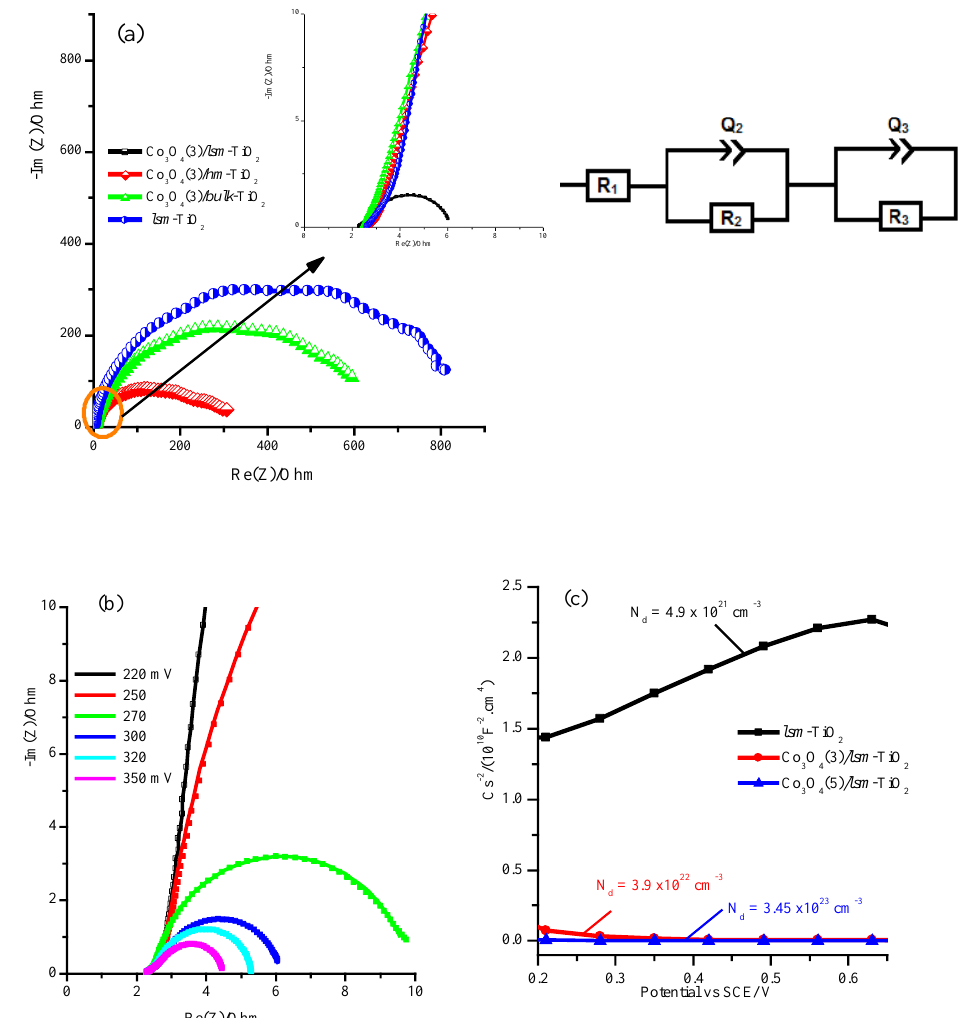
Figure 7. ( a ) Nyquist plots of lsm -TiO 2 , Co 3 O 4 (3) / lsm -TiO 2 , Co 3 O 4 (3) / hm -TiO 2 , and Co 3 O 4 (3) / bulk -TiO 2 electrodes in 1.0 M KOH solution, the inset is the equivalent circuit; ( b ) Nyquist plots of Co 3 O 4 (3) / lsm -TiO 2 at di ff erent overpotential ( η ); and ( c ) Mott − Schottky plot of pure lsm -TiO 2 , Co 3 O 4 (3) / lsm -TiO 2 and Co 3 O 4 (5) / lsm -TiO 2 electrodes measured at 500 Hz.